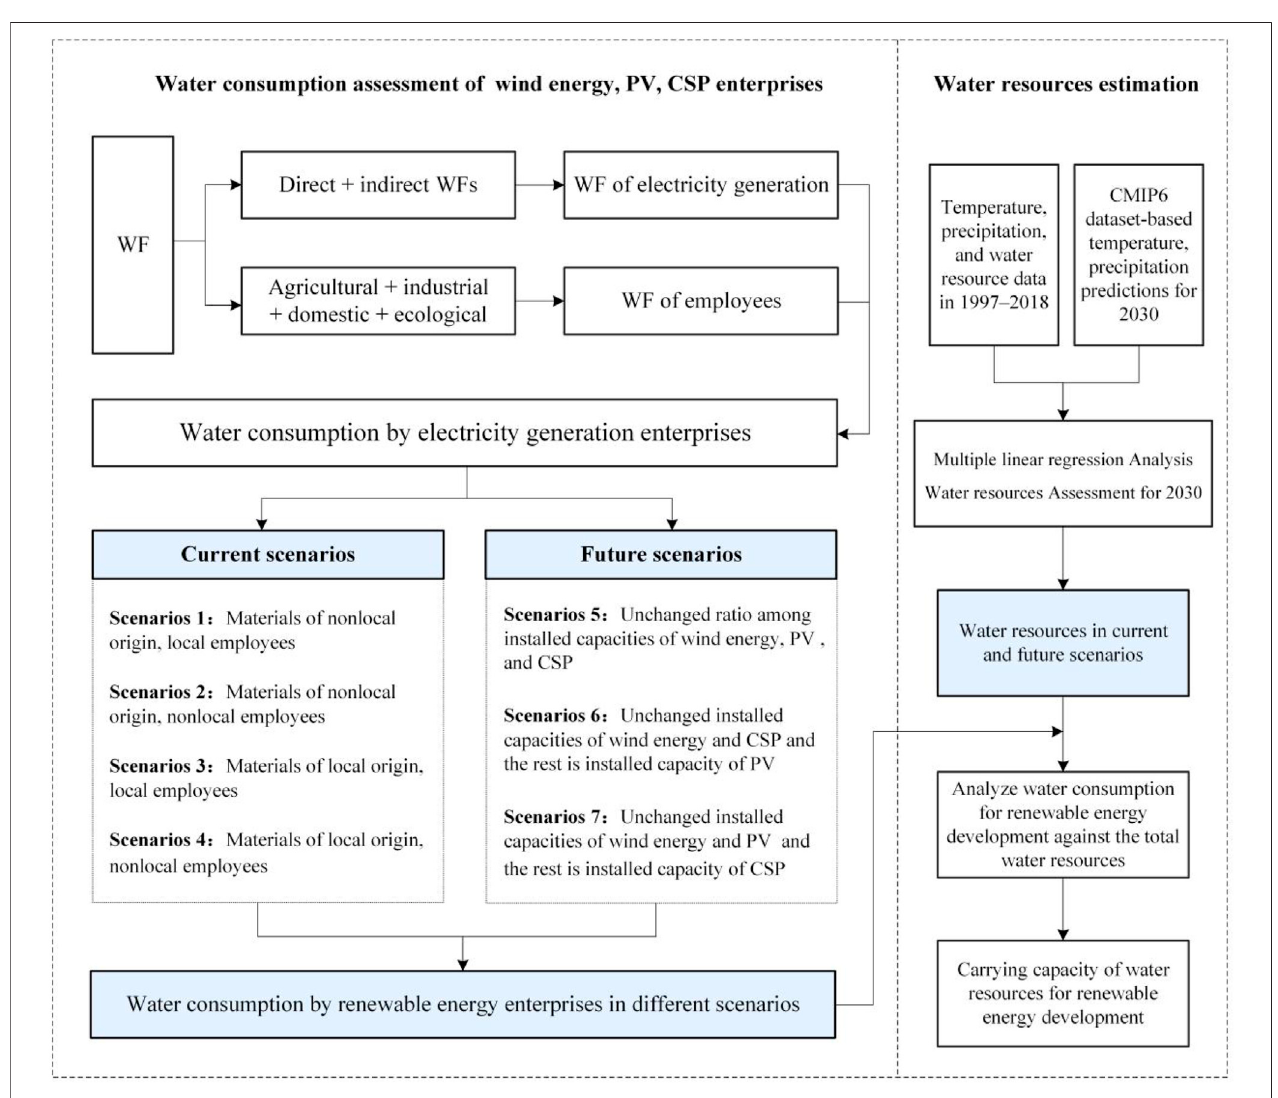
FIGURE 2 | Research framework of this